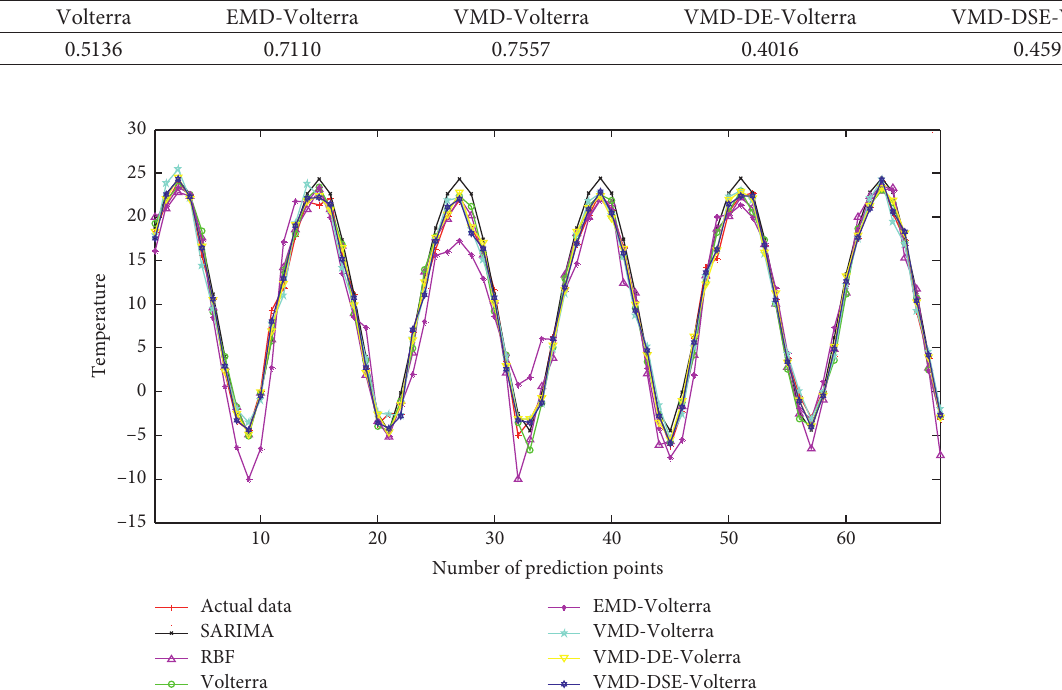
Figure 12: The prediction results for each model in